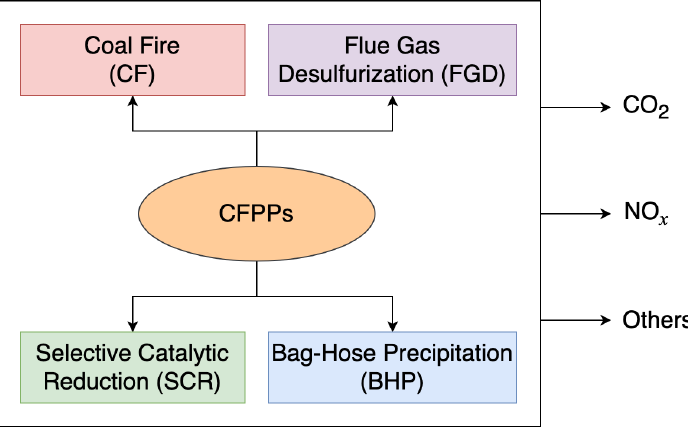
Figure 1. CO 2 emission boundary of coal-fired power